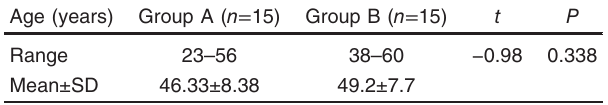
Table 1 Age of patients in both groups